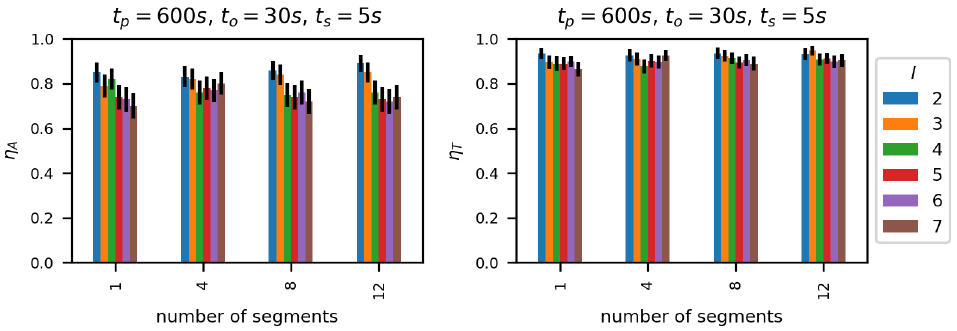
Figure 14. Number of segments impact on η A and η T